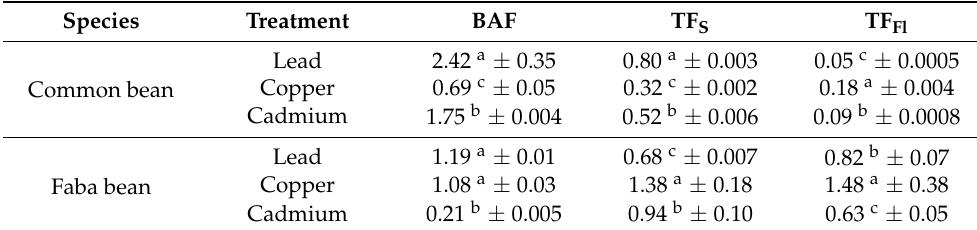
Table 6. BAFs and TFs for bean and faba bean plants at flowering stage.